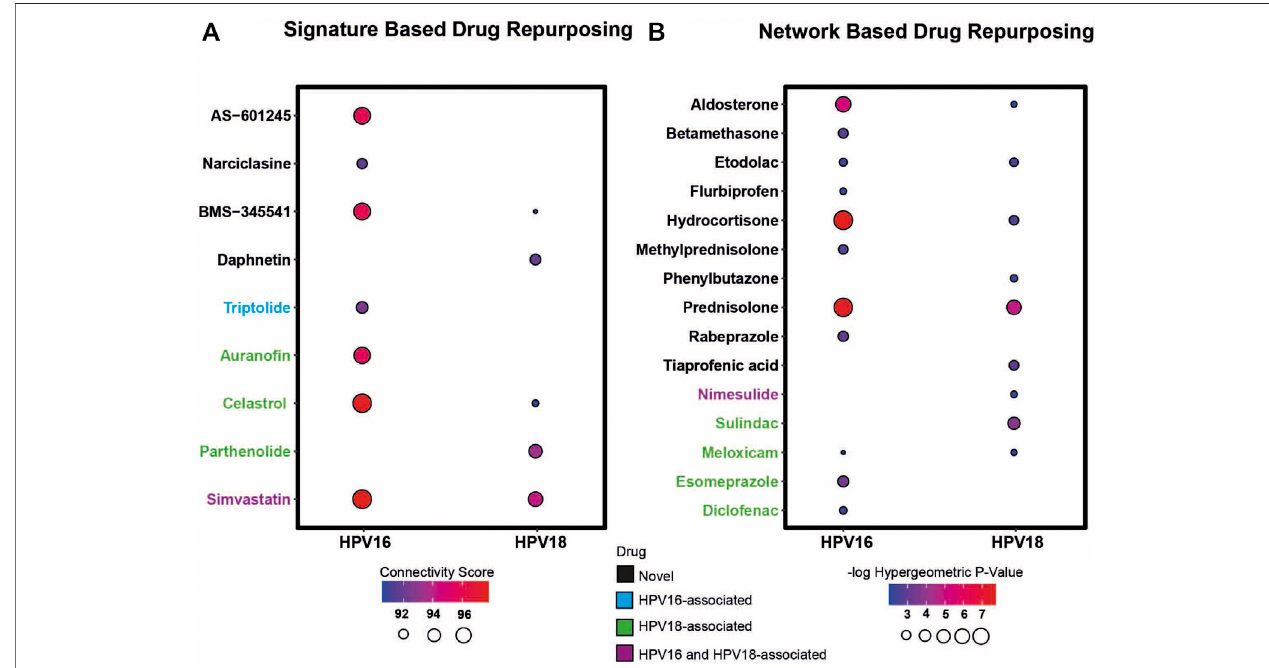
FIGURE 4 | The candidate drug targets that were revealed based on two different drug repurposing strategies (i.e. signature based and network based strategy). (A) The bubble plot indicates the drugs that resulted according to the signature-based drug repurposing strategy. (B) The bubble plot indicates the drugs that resulted according to network-based drug repurposing strategy. The drugs colored in black mean that the culminated drugs have not been associated with HPV16 or HPV18 subtypes of cervical cancer previously and novel. The drugs colored in blue, green, and purple means the culminated drugs have been associated with HPV16, HPV18 and with both subtypes of cervical cancer